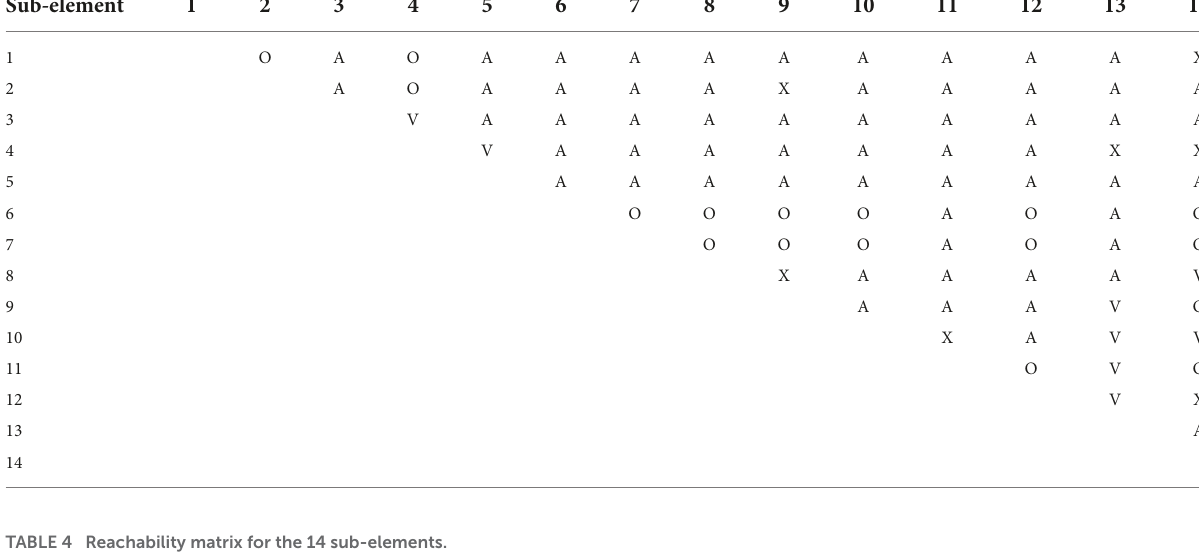
TABLE 4 Reachability matrix for the 14